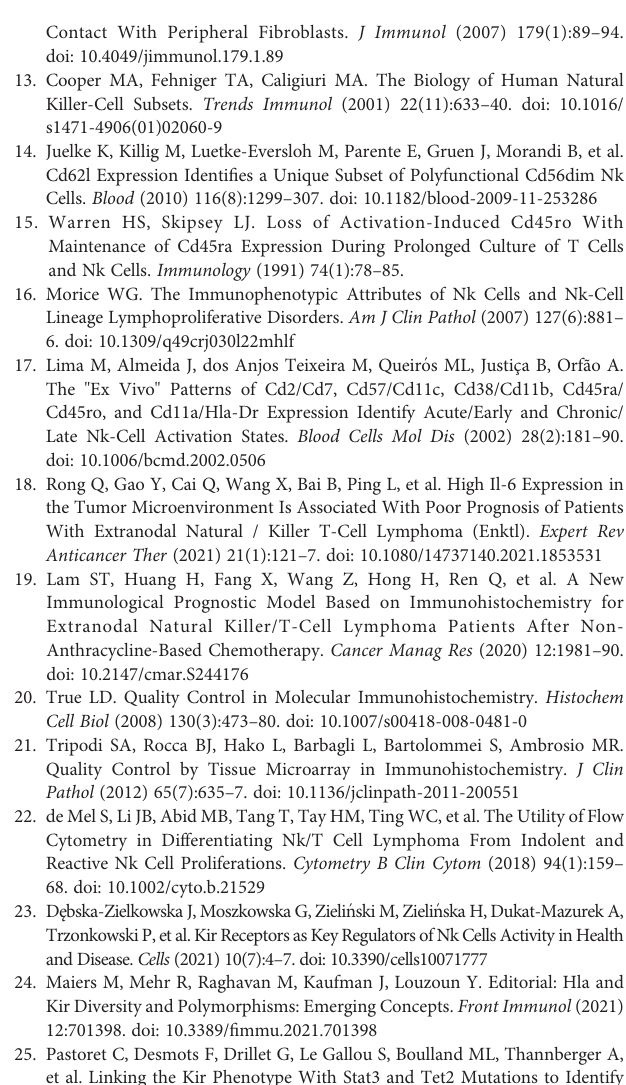
Supplementary Figure 2 | Different progression of reactive and malignant NK cells. Reactive NK cells arise in response to immune stimulation and can induce reactive polyclonal or secondary monoclonal proliferation. Reactive NK cells tend to disappear after the disappearance of the stimulus. Supplementary Table 1 | The clone number of the antibodies used. Supplementary Table 2 | p-values for differences between